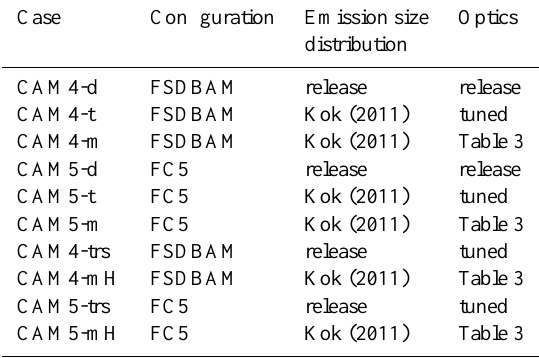
Table 4. Description of the model simulations used in this study. All cases are 8-year simulations, with the last 6 years used for anal- ysis. All cases are run at 1.9 ◦ × 2.5 ◦ resolution. FSDBAM indi- cates CAM4 physics, bulk aerosols, active atmosphere, land and sea ice components, data ocean, slab glacier and GEOS5 meteorology. FC5 indicates CAM5 physics, modal aerosols, stand-alone atmo- sphere with land and sea ice components, data ocean, slab glacier and GEOS5 meteorology. Default, tuned and tuned plus mineral- ogy cases are listed in the upper portion of the table, and the lower portion of the table designates the simulations part of the sensitivity study section. The suffix “-m” refers to the prescription of hematite from both fine and coarse soil fractions, while the suffix “-mH” refers to hematite prescribed solely from the fine soil